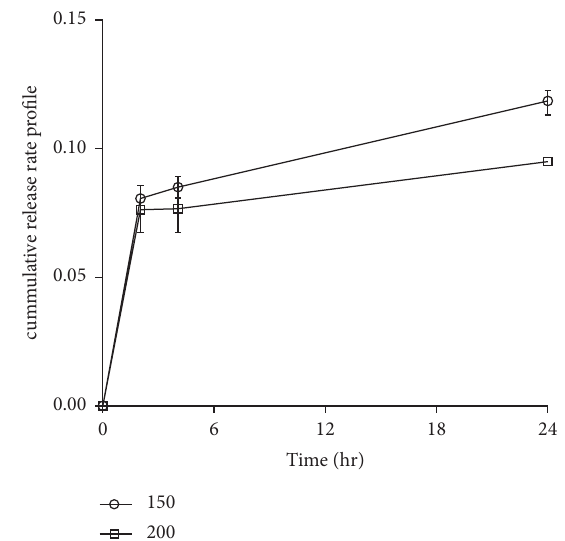
Figure 12: Te AgNPs’ release profle from DFS scafold at dif- ferent time intervals. Error bars shown in fgures are the standard deviation of triplicate measurements.